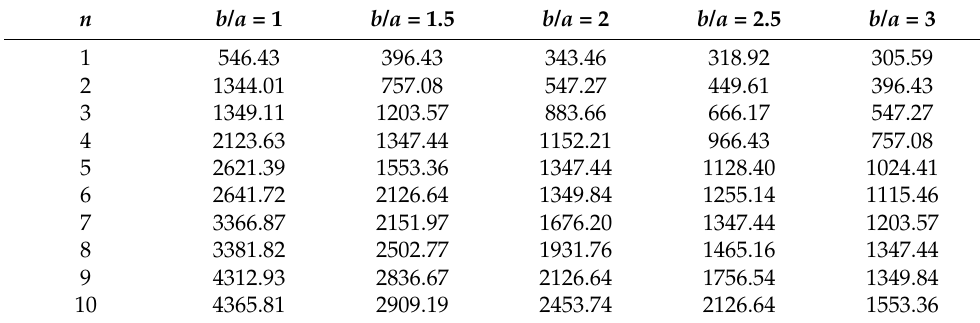
Table 7. Frequencies with length–width